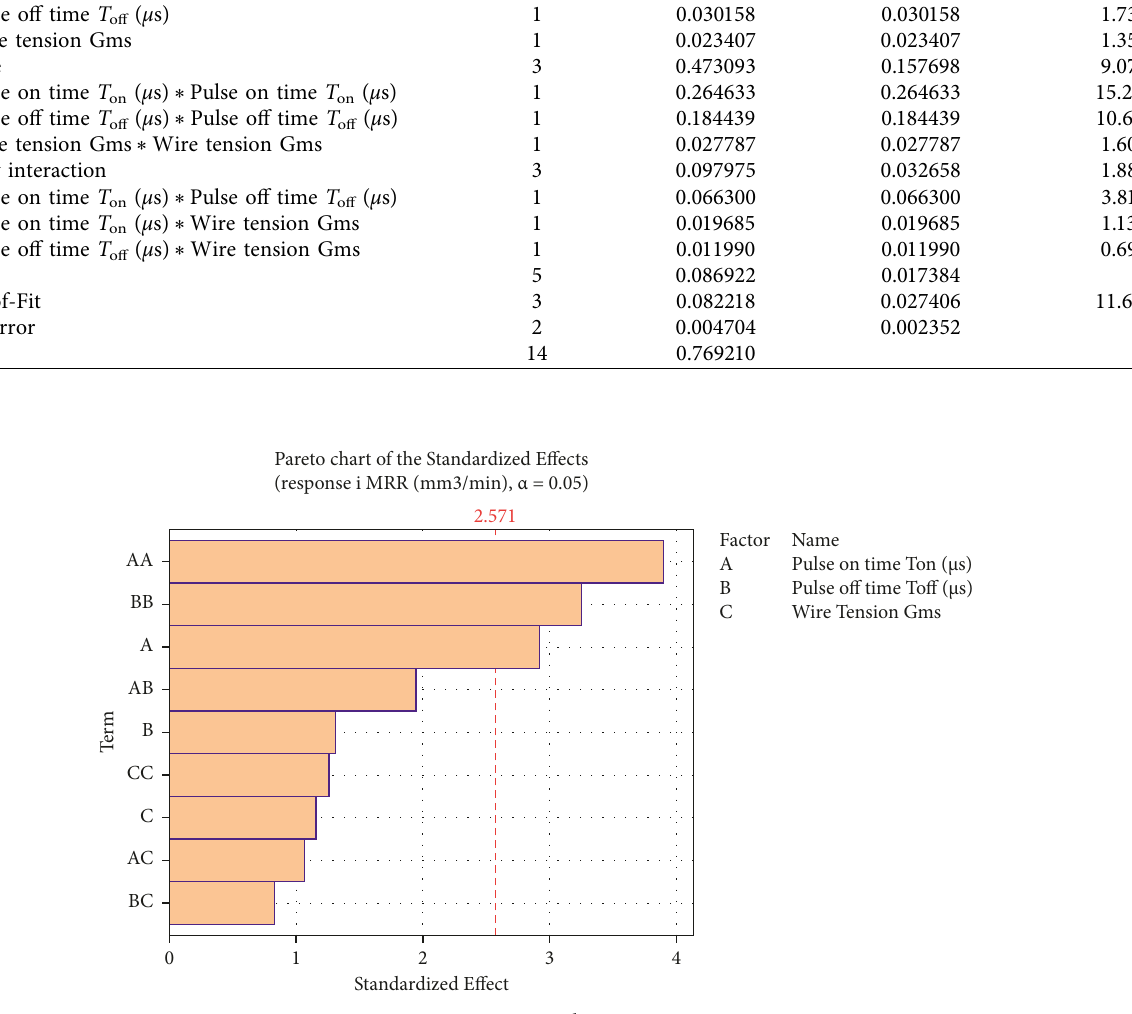
Figure 3: Pareto